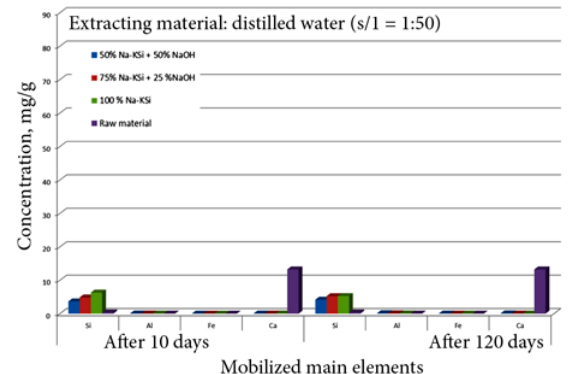
Fig. 8. Quantity of mobilized main elements in distilled water from 10 and 120 days age geopolymers formed using different alkaline activator solutions (solid/liquid ratio 1:50)